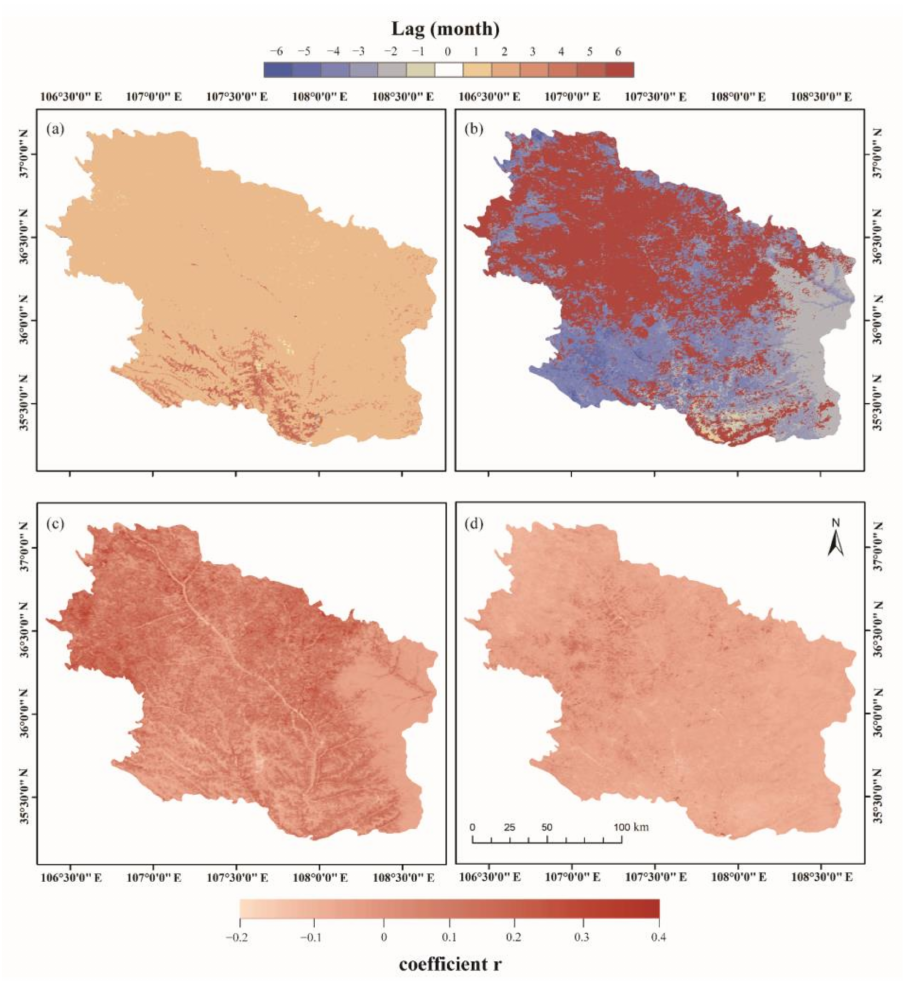
Figure 12. Cross-correlation results between FVC and DMI ( a , c ), ONI ( b , d ). The best time lags ( a , b ), and the corresponding correlation coefficients ( b , d ) were